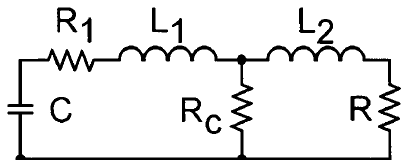
FIG. 8. LTD cavity equivalent circuit including core losses represented with the resistance R c . Here R 1 and L 1 are the cavity total resistance and inductance and L 2 is the inductance of the load.